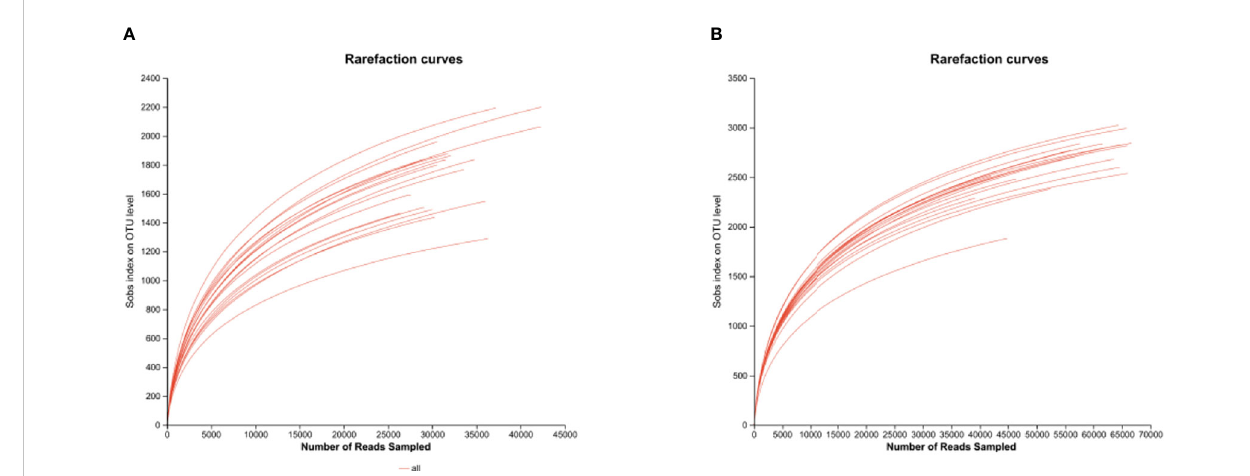
FIGURE 5 Bacterial dilution curve of tomato rhizosphere soil. (A) Spring (B) Autumn.